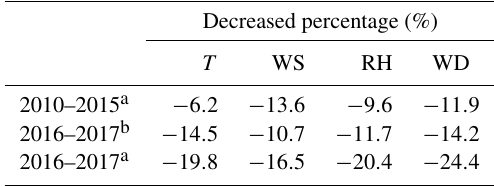
Table 2. Comparison of the average percentage decline in CO mix- ing ratios during 2010–2015 and 2016–2017 relative to CO mixing ratios in previous time intervals under the same meteorological fac-